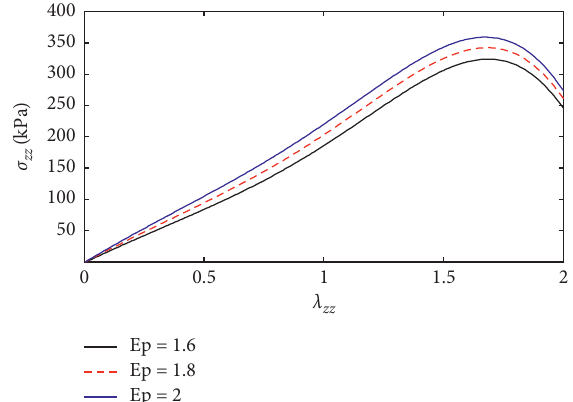
Figure 11: Study of the influence of the elasticity modulus on axial stress.